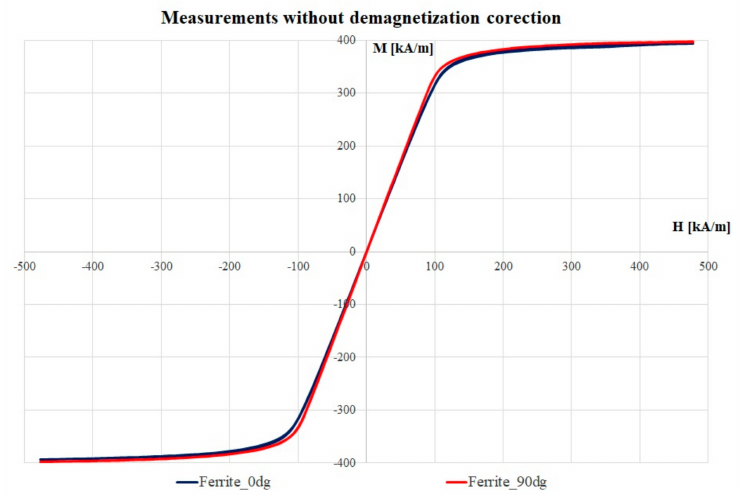
Figure 5. Measured hysteresis loops obtained for the investigated sample, considering the applied field in the plan of the sample (blue) and perpendicular to the sample plan (red),